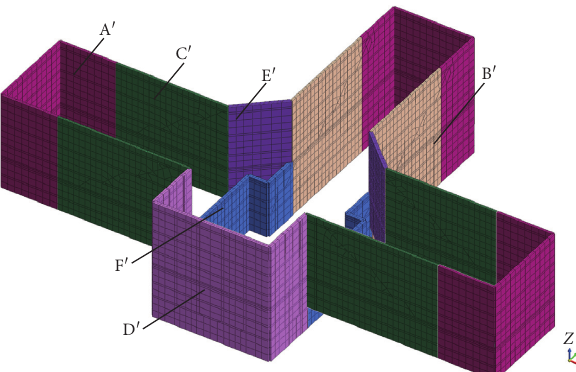
Figure 11: Distribution of the diaphragm wall.